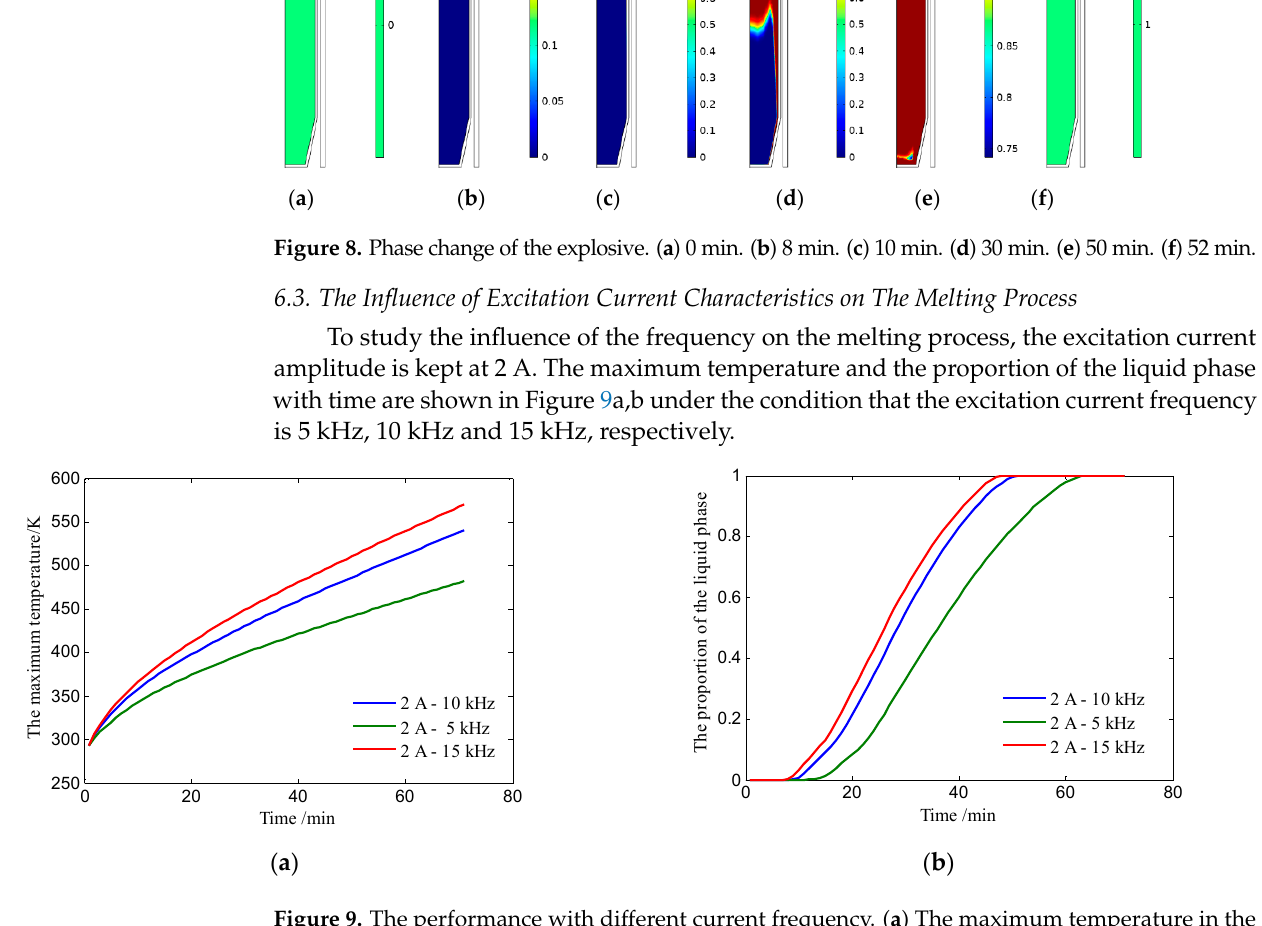
( b ) Figure 10. The performance with different current amplitude. ( a ) The maximum temperature in the explosive. ( b ) The proportion of the liquid phase. As Figure 10 shows, the larger the excitation current amplitude, the faster the tem- perature rise. The times that the explosive begins to melt and melts thoroughly are 17 min and 78 min, respectively, when the excitation current amplitude is 1.5 A. The two times are 8 min and 52 min, respectively, with the excitation current amplitude of 2 A, and 5 min and 40 min, respectively, with the excitation current amplitude of 2.5 A. The